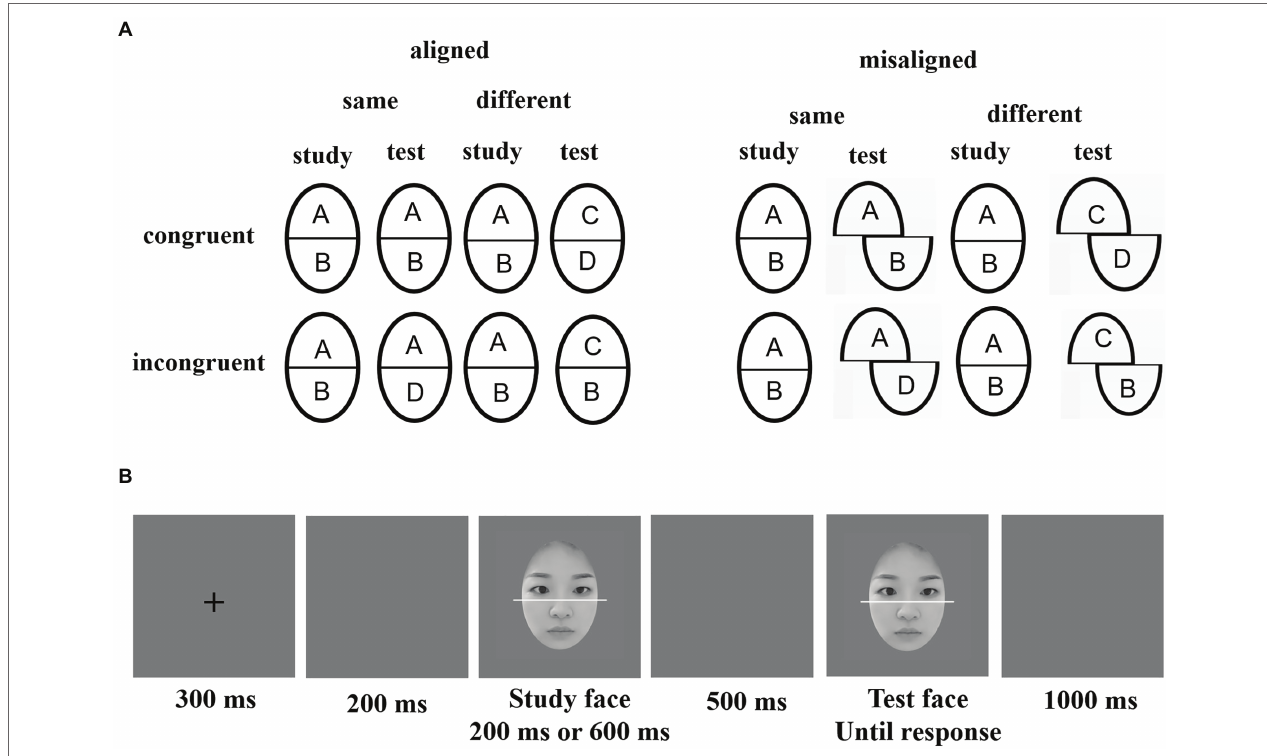
FIGURE 1 | (A) Schematic diagram of the composite face task in a complete design. (B) Example for the aligned-congruent condition for one trial. Participants need to pay attention to the top half of the study face, while ignoring the bottom half, and indicate whether the top part of the test face is the same as the study face. The study faces are always presented in aligned form, and the test faces may be presented in aligned or misaligned